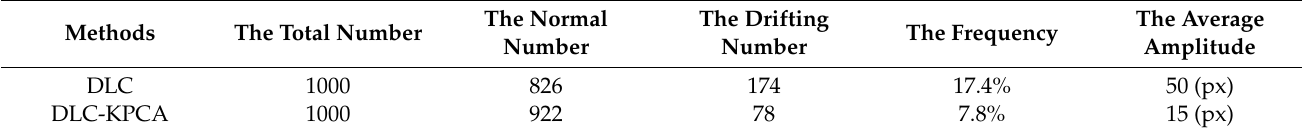
Table 4. Comparative statistics of the frequency and amplitude of abnormal trajectory